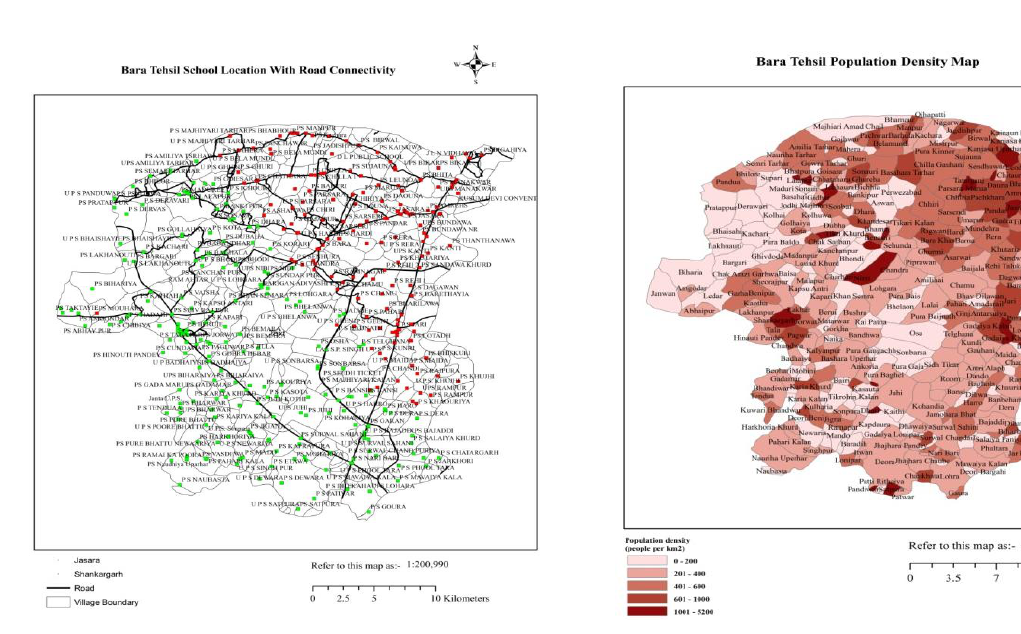
Figure 9. Bara tehsil population density